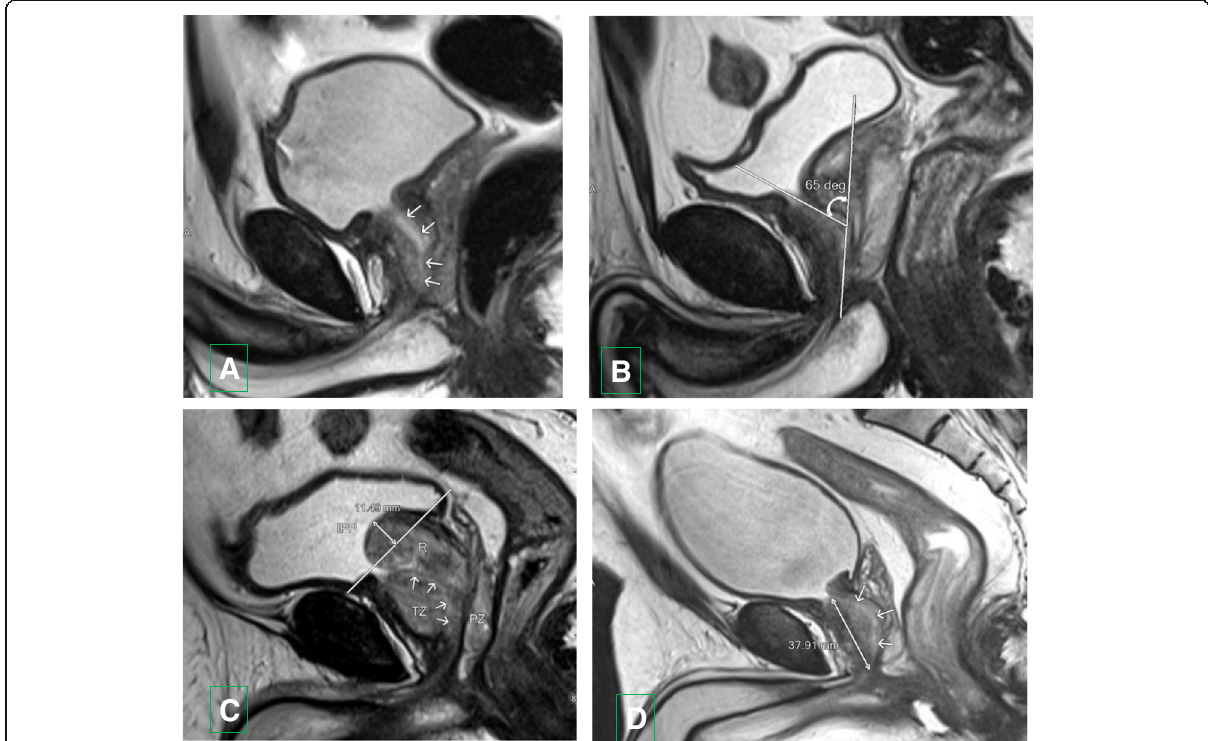
Fig. 2 Midsagittal T2-weighted MR images in different patients with BPH showing a The prostatic urethra (arrows). b Measurement of the prostatic urethral angle (PUA) (curved arrow); the acute angle between the proximal prostatic urethra and the distal prostatic urethra. c Measurement of the intravesical prostatic protrusion (IPP) (double-headed arrow). Retrourethral (median) lobe enlargement (R), transition zone (TZ), peripheral zone (PZ), and prostatic urethra (arrows) are noted. d Measurement of the AFMS distance (double-headed arrow). Prostatic urethra (arrows) is